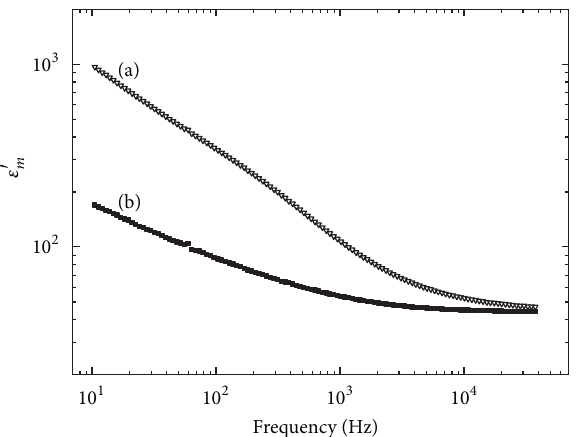
Figure 8: Dielectric permittivity as function of the frequency of the ceramics sintered at 750 ∘ C/1h, using the powders calcined at (a) 450 ∘ C/1h and (b) 600 ∘